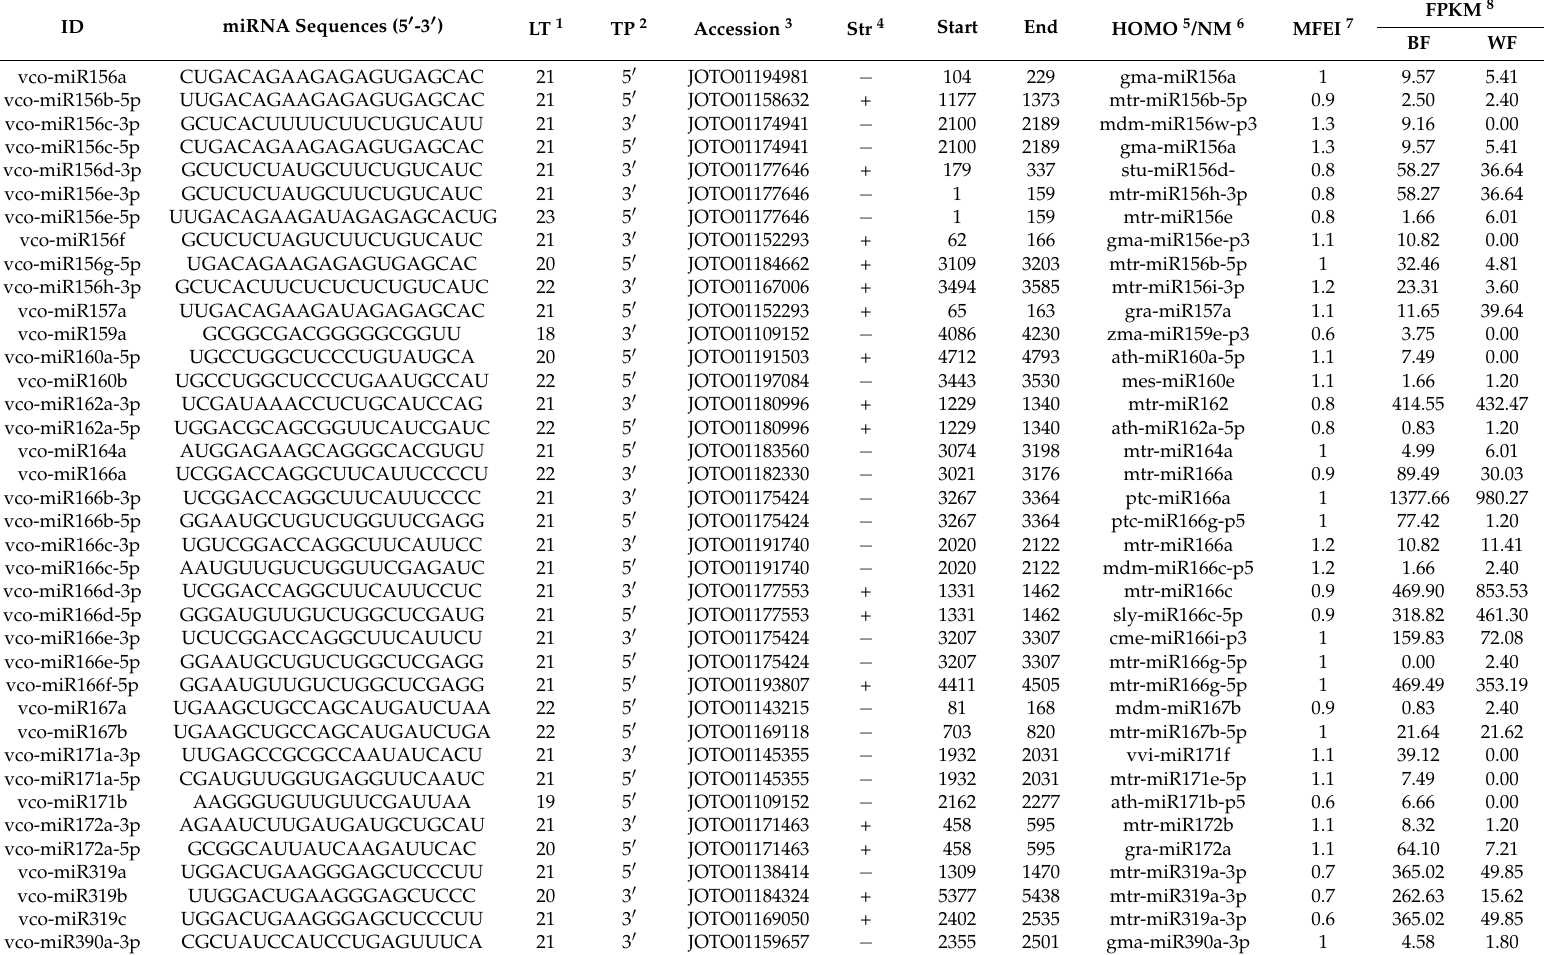
Table 1. Characteristics of total miRNAs identified from BF (blue fruit) and WF (white fruit) libraries in